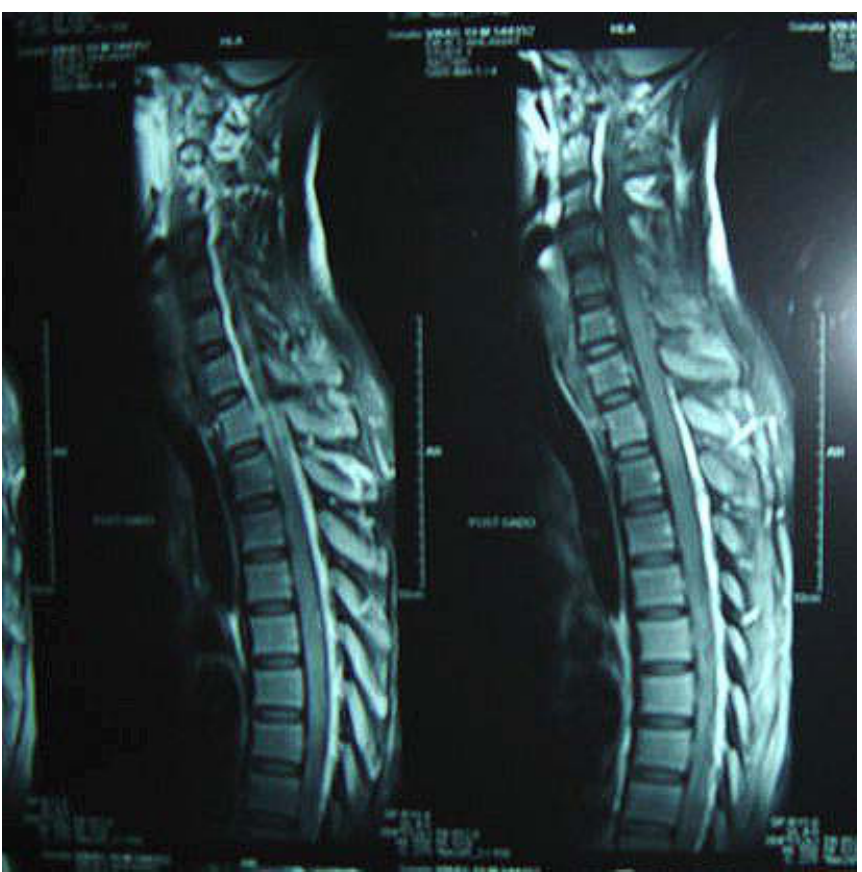
Fig. 1 Spine MRI showing area of cord edema and hyper intense signals (on T2W images) in dorsal cord extending from D2 – D9 vertebral